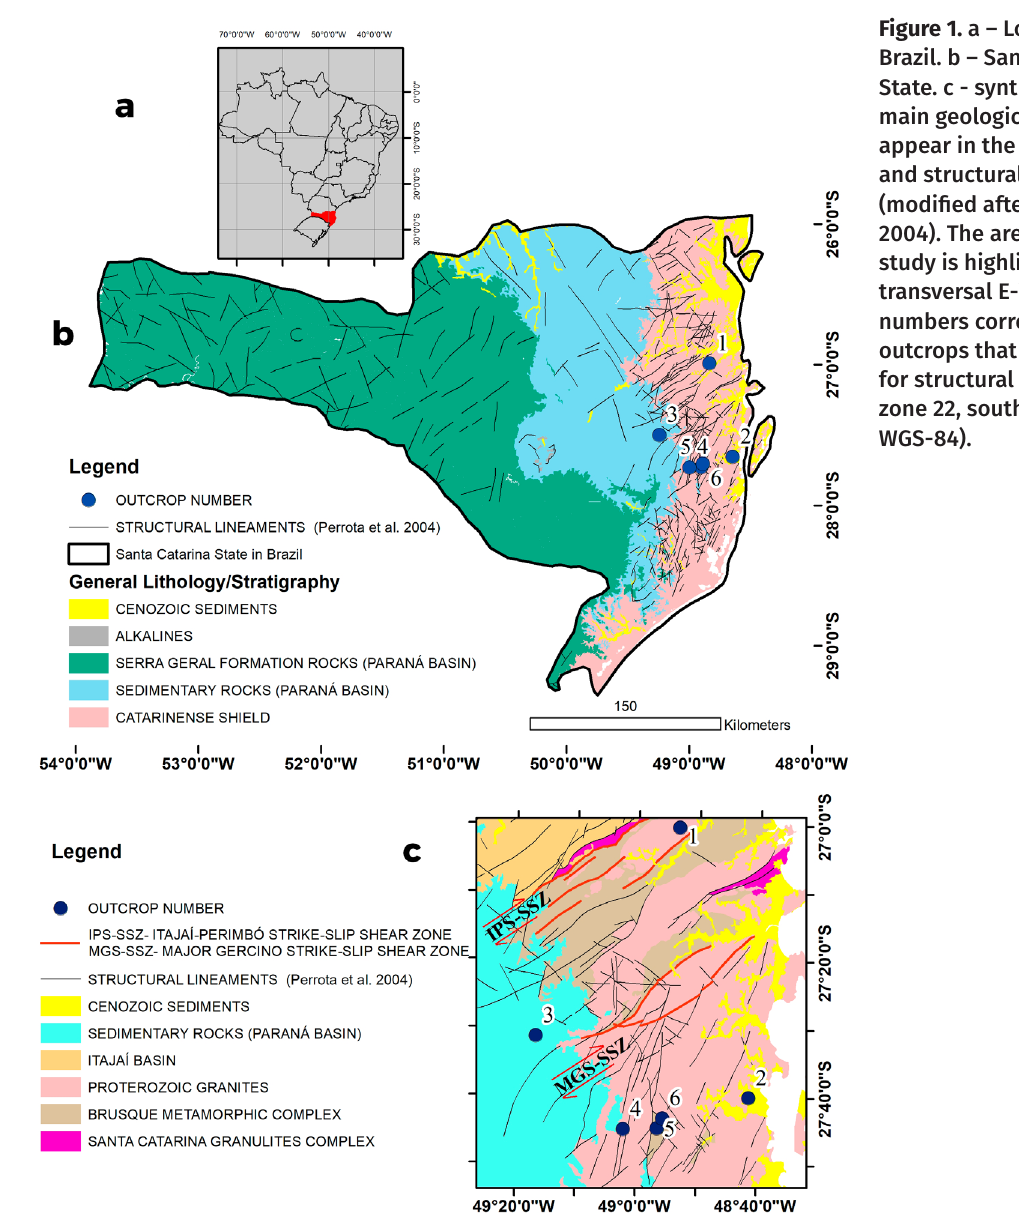
Figure 1. a – Location in State. c - synthesis of